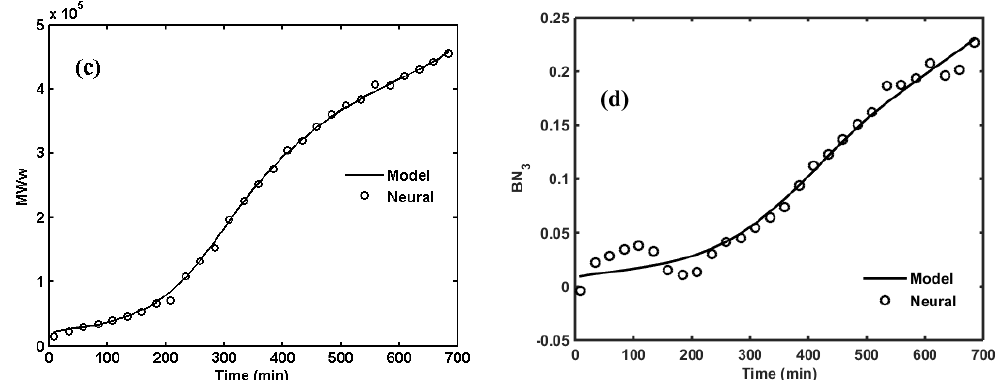
Figure 1. Comparison of ( a ) conversion, ( b ) cumulative copolymer composition, ( c ) weight-average molecular weight, and ( d ) tri-functional branching frequency profiles obtained using ANN and mechanistic models. For process conditions, refer to Dube et al. [2].